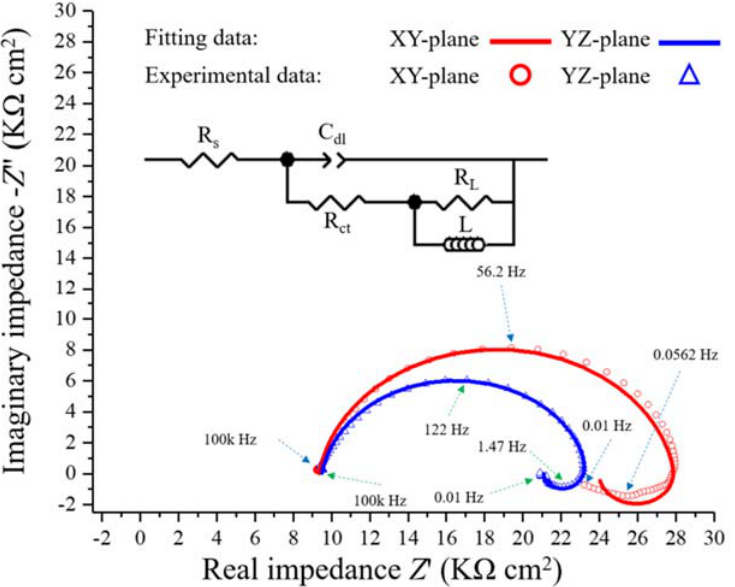
Figure 8. Complex plane impedance plots for the LMD-produced Fe 50 Mn 30 Co 10 Cr 10 HEA in 0.1 M H 2 SO 4 solution at 25 °C.